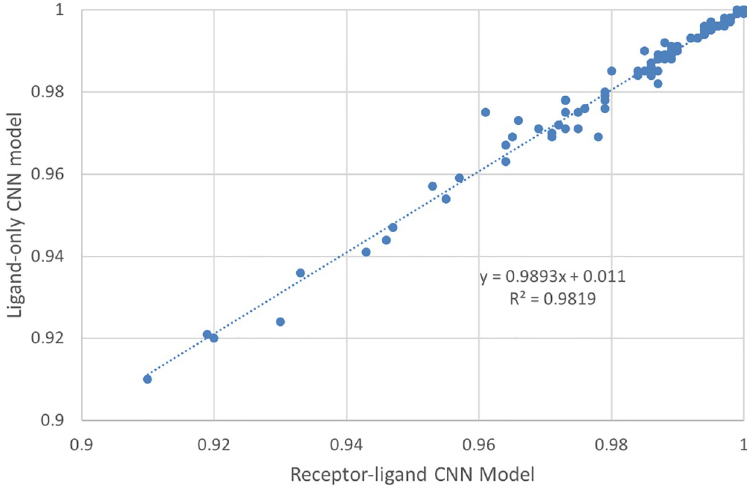
Fig 4. Correlation between the performance of the receptor-ligand CNN model and ligand-only CNN model. The receptor-ligand CNN model was trained on receptor-ligand 3D binding poses, and the ligand-only CNN model was trained on ligand binding poses alone. Each blue dot is a target from DUD-E; there are 102 targets in total.